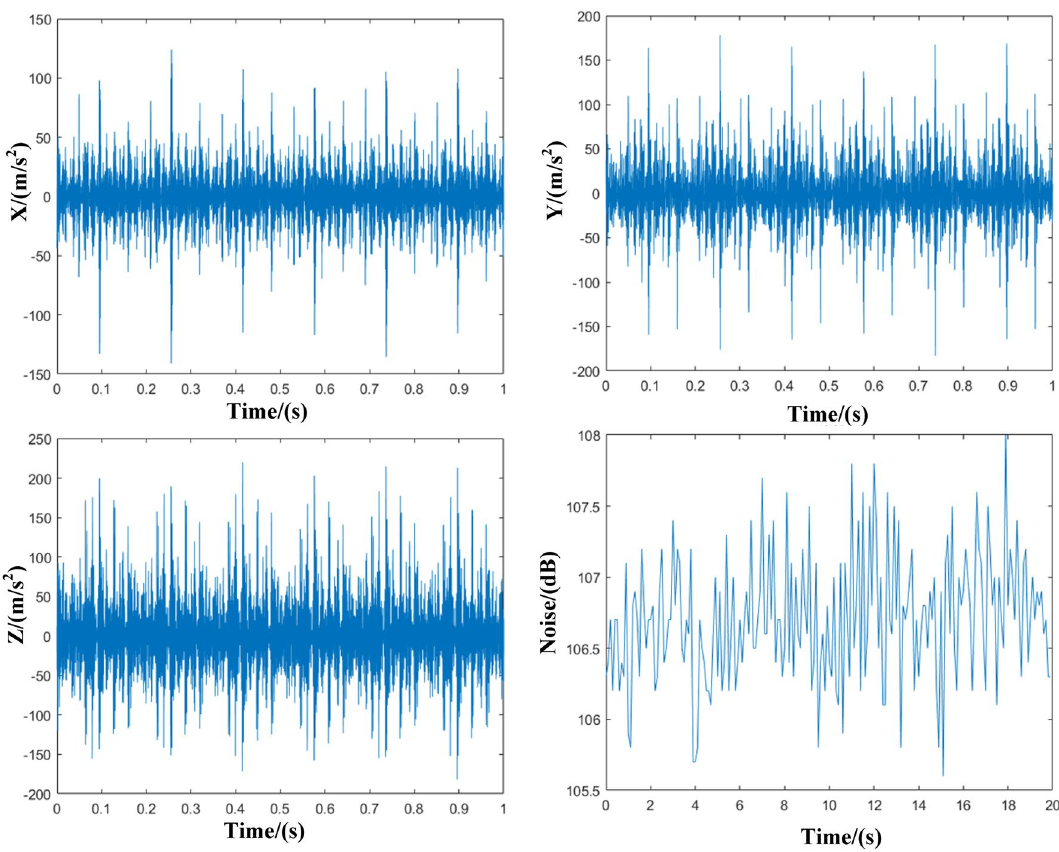
Figure 3. Measurement results of vibration and noise.